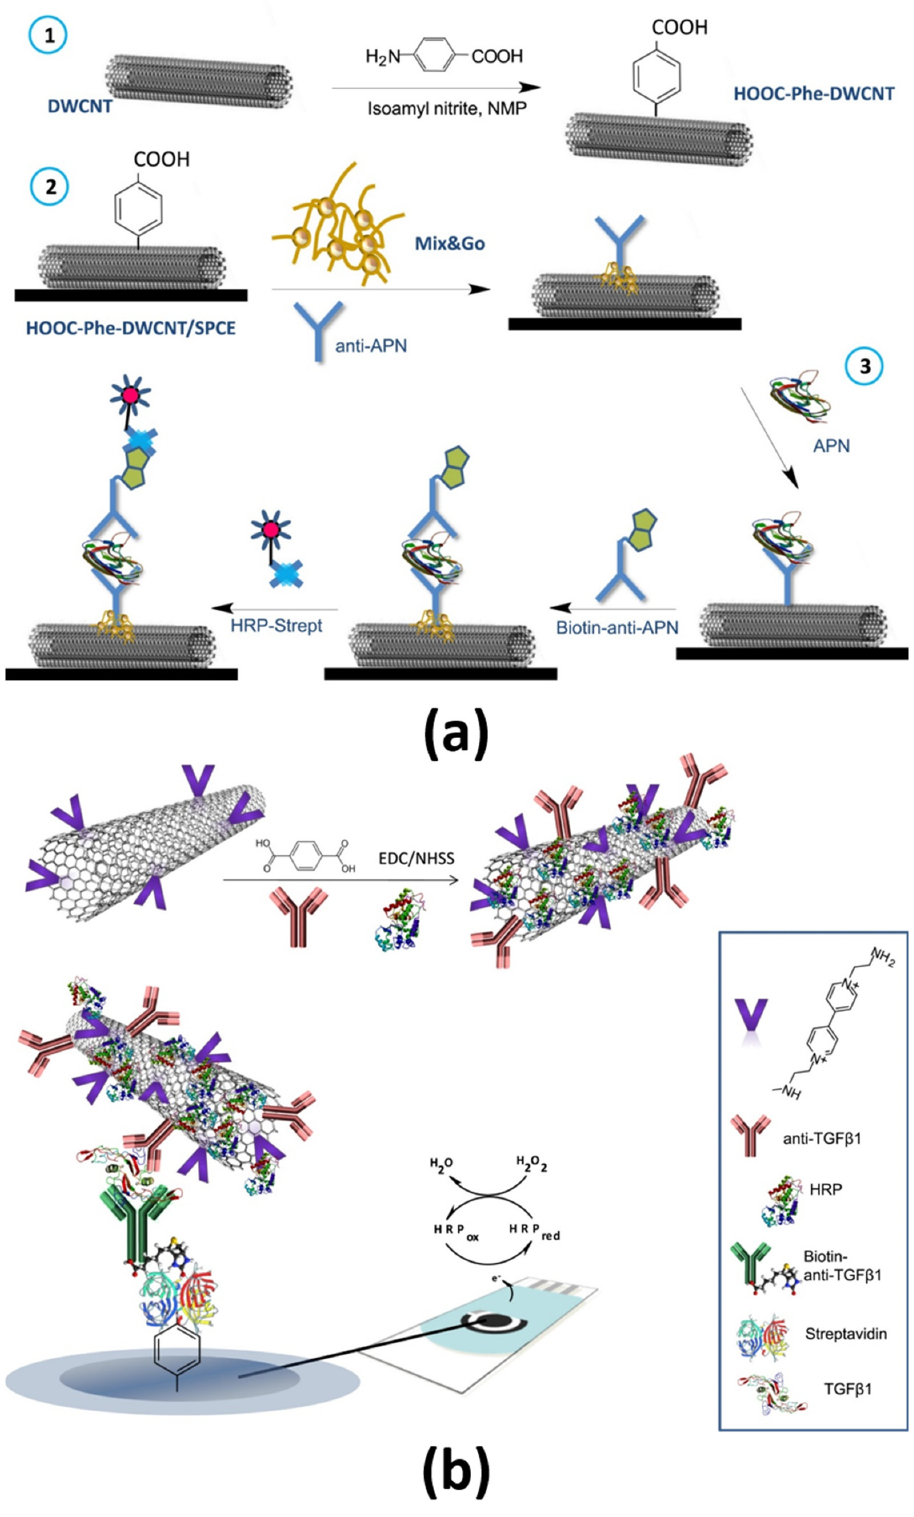
Figure 4. ( a ) Modification of SPCE with p -ABA-DWCNTs and ( b ) use of V-Phe-SWCNTs as nanocarriers of DAb and HRP molecules for the preparation of amperometric sandwich immunoplatforms for the determination of APN and TGF- β 1, respectively. Reproduced from ( a ) [27] and ( b ) [43] with permission.